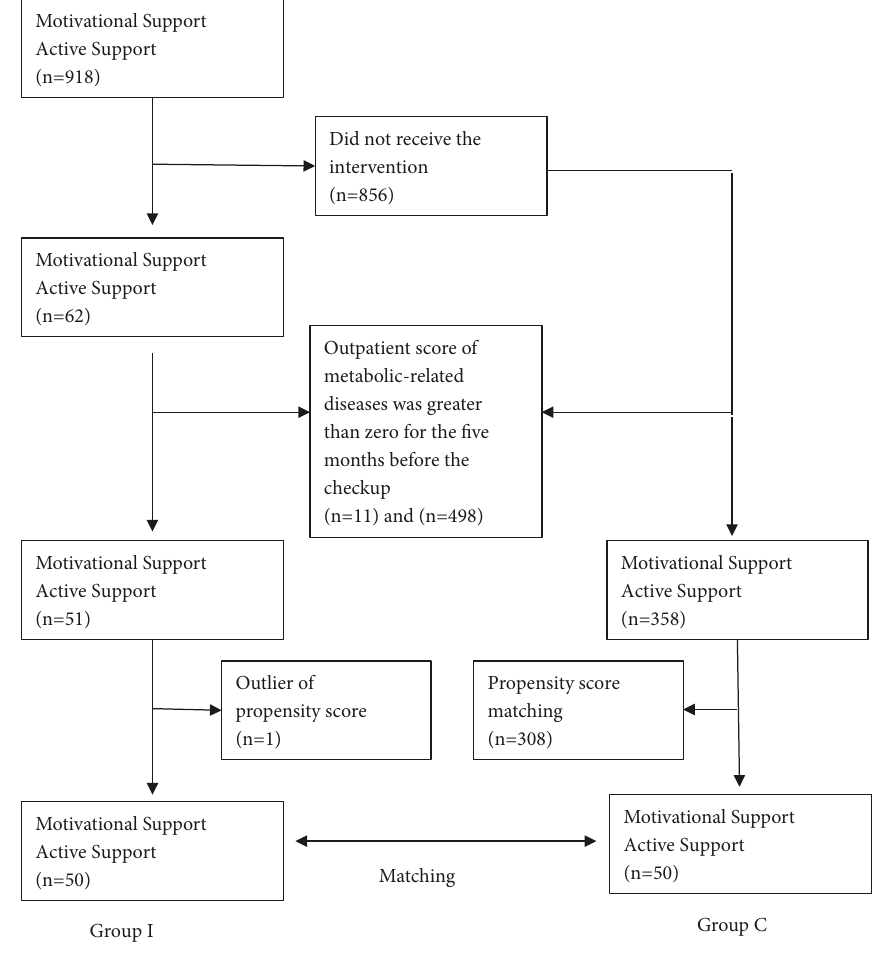
Figure 1: Sampling flow diagram.